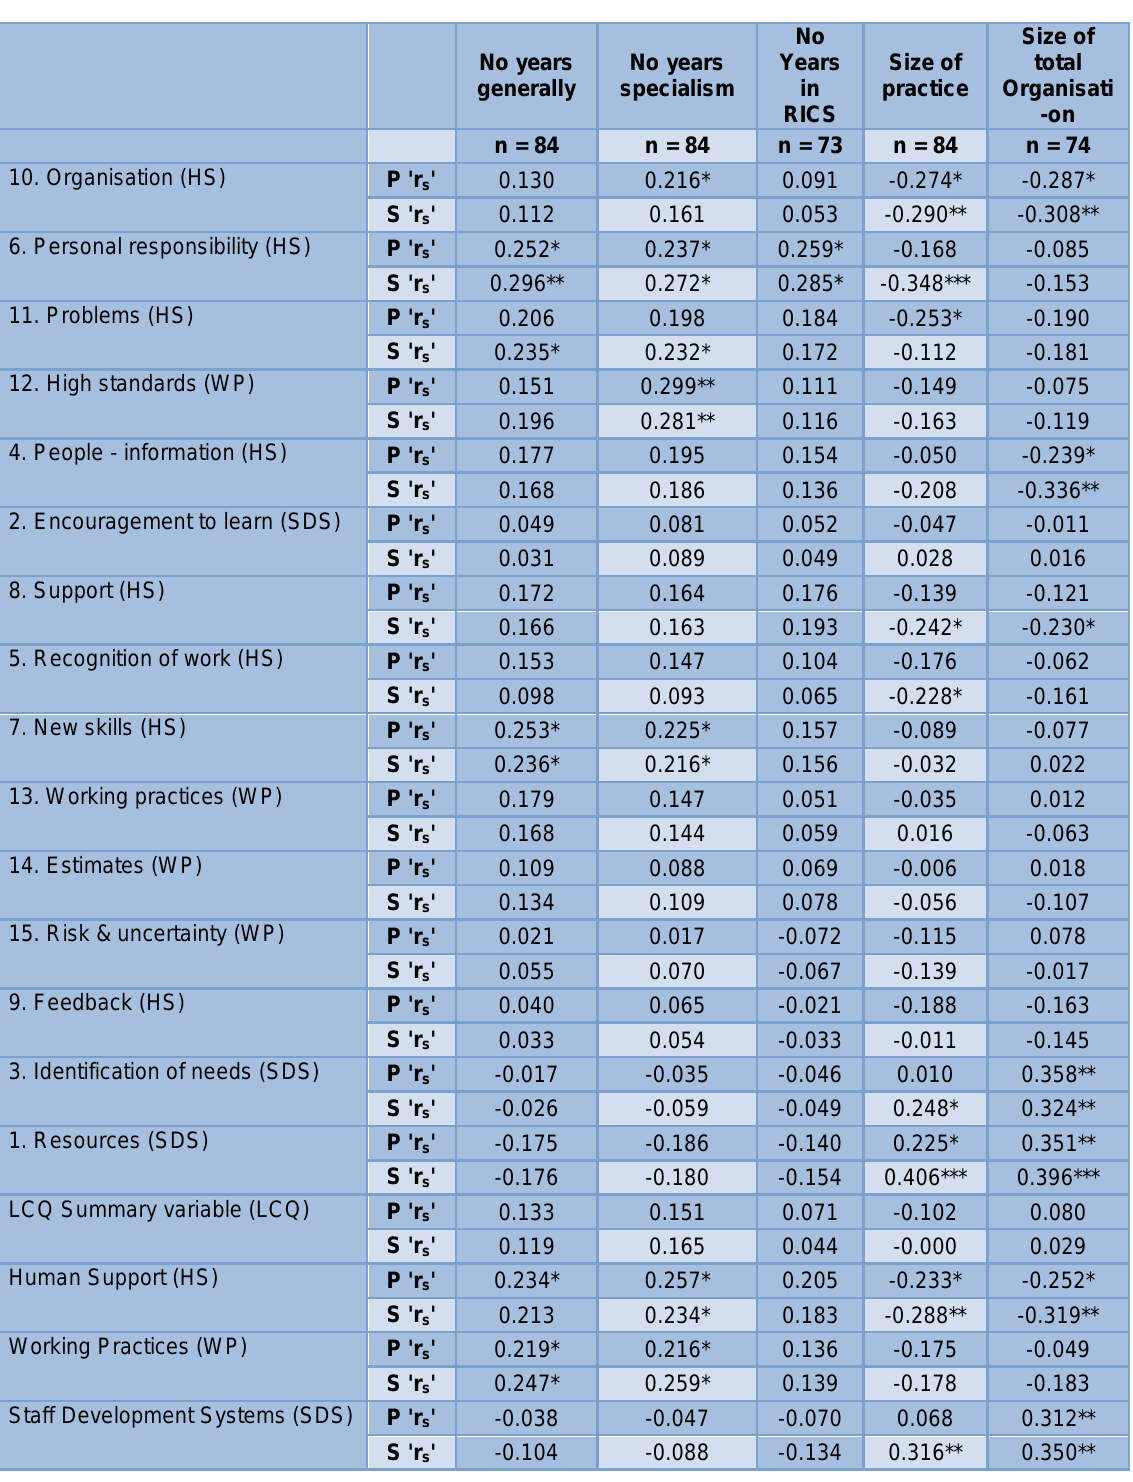
Table 4 Correlations between Learning Climate Questions and Number of years experience and size of